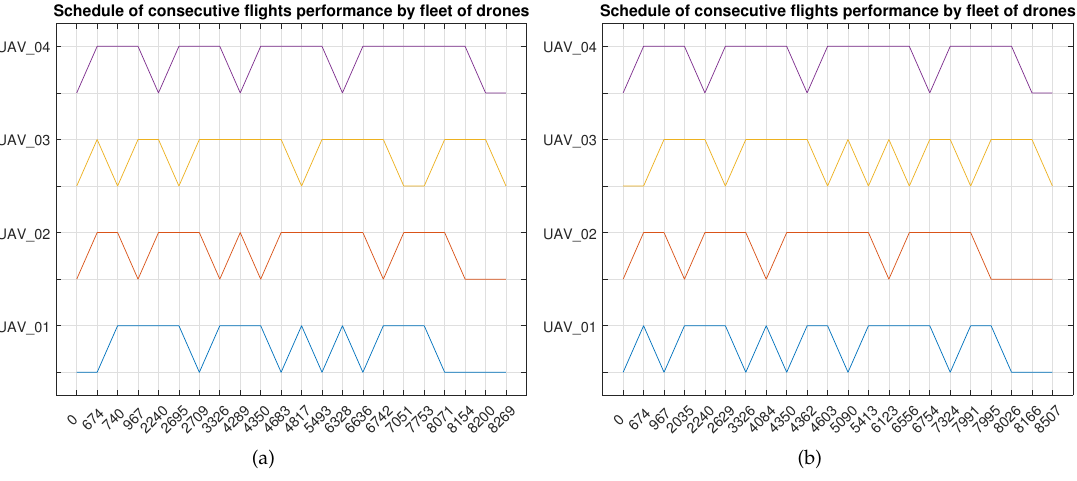
Figure 1. Schedule of consecutive flights’ performance by fleet of four drones. ( a ) the shortest and ( b ) the longest time. Further simulations were carried out for a randomly determined fleet of seven drones and 29 tasks, in which the solution with the shortest time of 6401 [ s ] and the longest time of 7199 [ s ] , respectively, was obtained (see Table